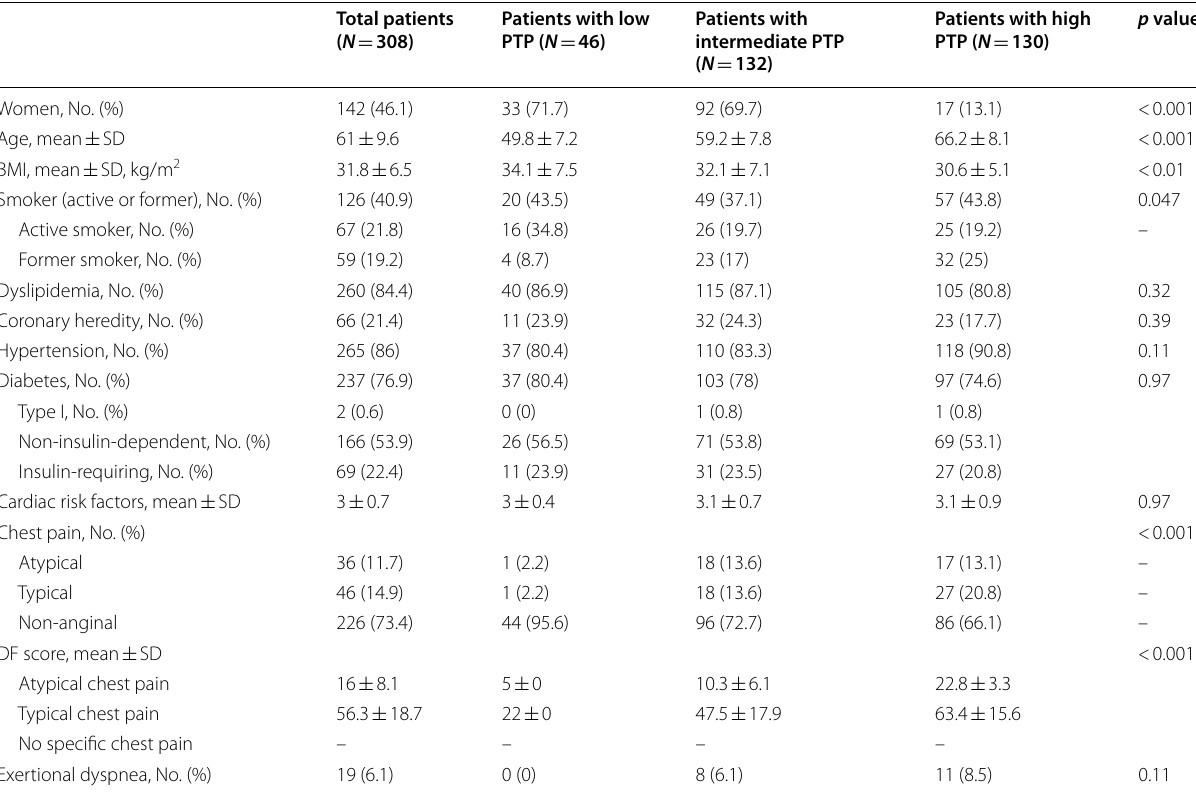
Table 1 Baseline characteristics of RUBIS patients